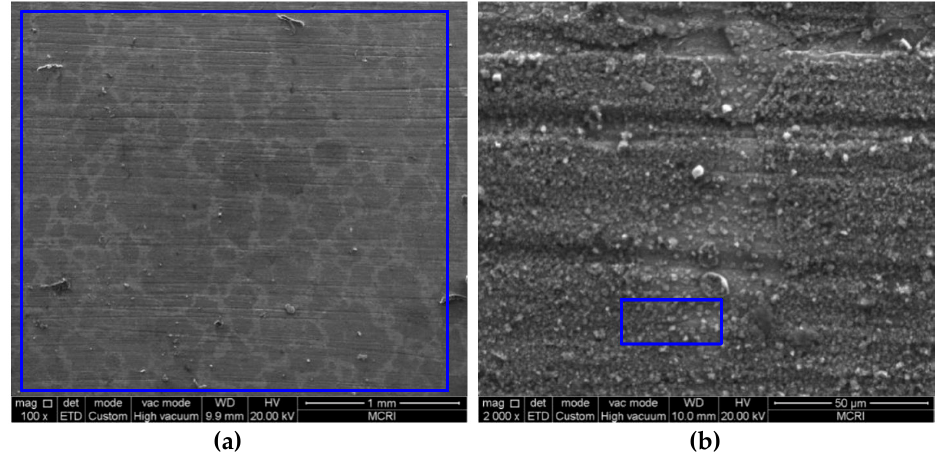
Figure 9. SEM images of corrosion scales formed on the steel surface in 30% crude oil/brine mixtures at Pco 2 = 15.0 MPa: ( a ) × 100; ( b ) × 2000. Table 3. EDS of the corrosion scale of immersion in 30% crude oil/brine mixtures under different CO 2 partial pressures. Element (At. %)